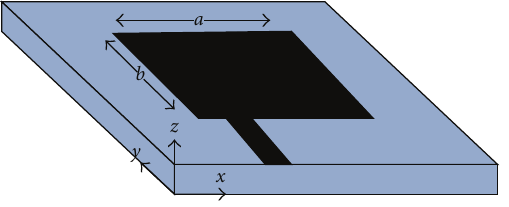
Figure 2: Geometrical structure of the planar microstrip antenna.